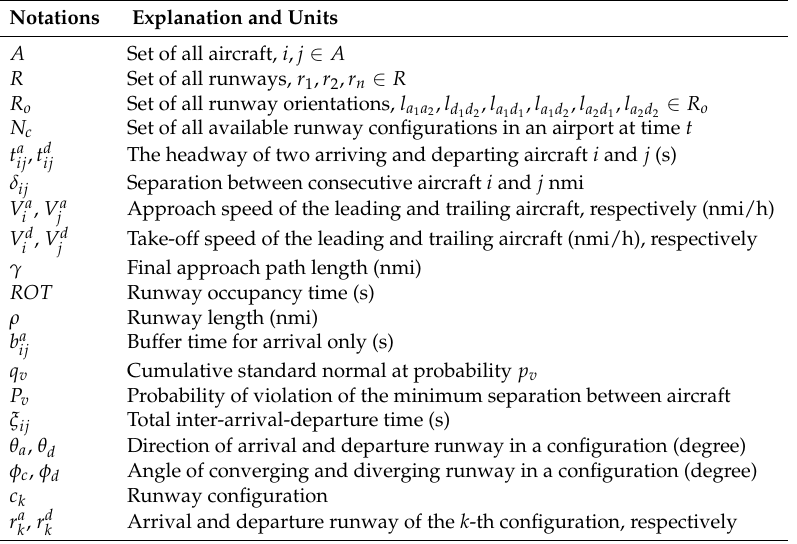
Table 1. Notation and units of the variables.